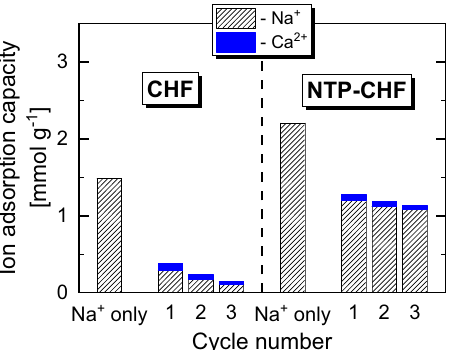
Fig. 6 Changes in ion adsorption capacity at various Na + :Ca 2 + ratio. Note that the Na + concentration and the applied electric potential were fi xed at 8.6 mM and 1.3 V, respectively. Error bars represent standard